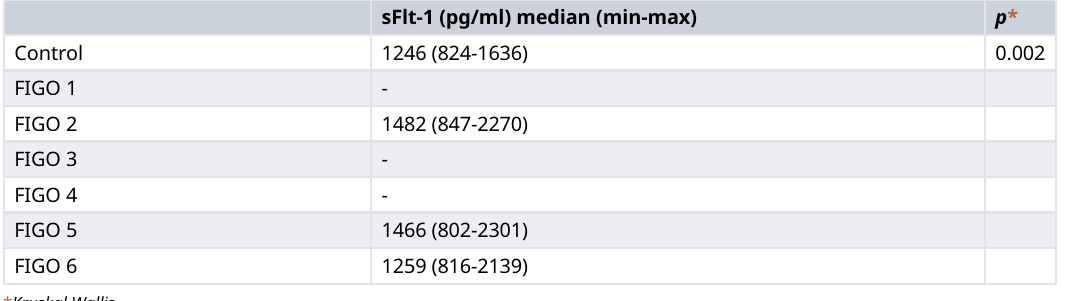
Table 3. Post-Hoc analysis of sFlt-1 level based on FIGO.